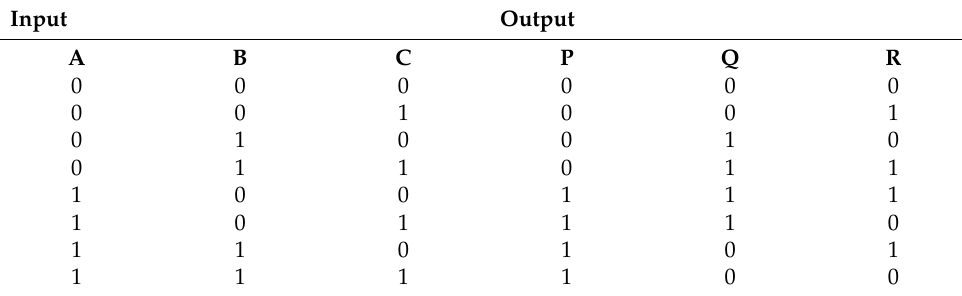
Figure 3. ( a ) The logical diagram of the double Feynman gate, and ( b ) the QCA-based diagram of the double Feynman gate [16]. Table 1. The truth table of the double Feynman